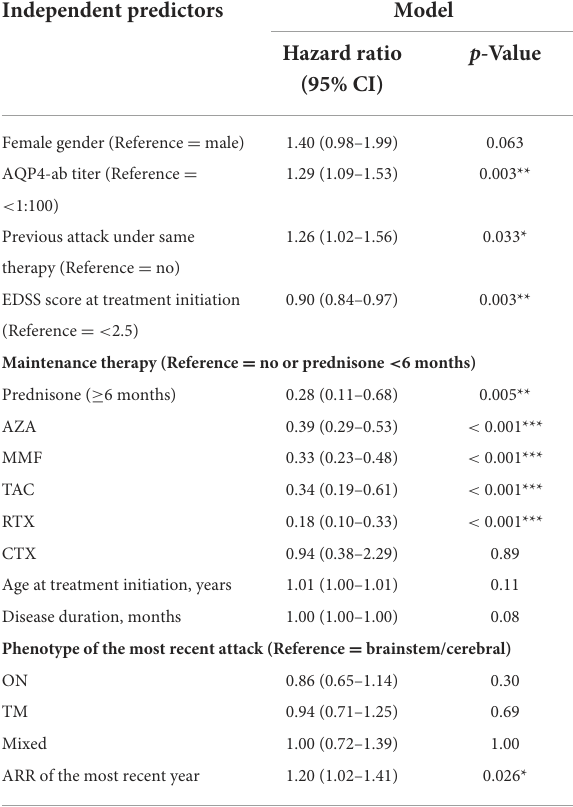
TABLE 2 Independent predictors of relapse with multivariate Cox-PH